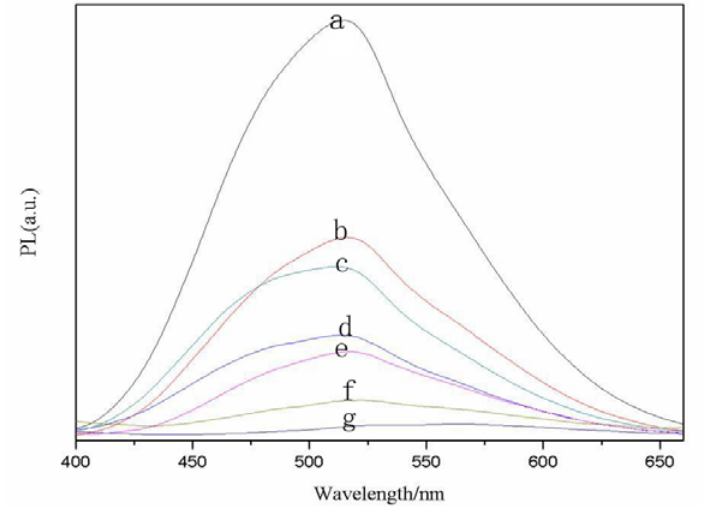
Figure 1. PL spectra of the CdSe quantum dots at different temperatures (a, 0 °C; b, 10 °C; c, 20 °C; d, 40 °C; e, 60 °C; f, 80 °C; g, 100